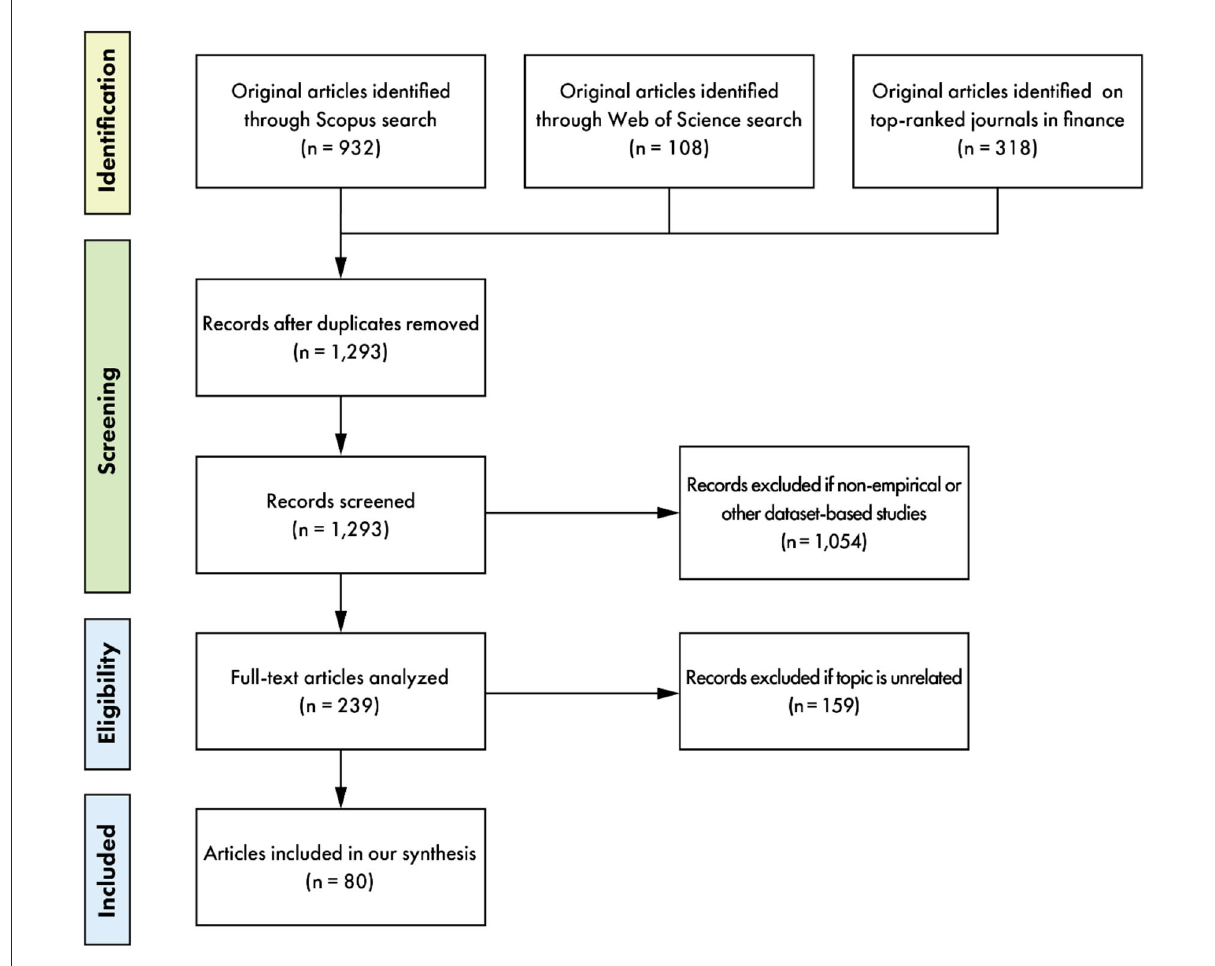
FIGURE1 Screening procedure of ESG literature